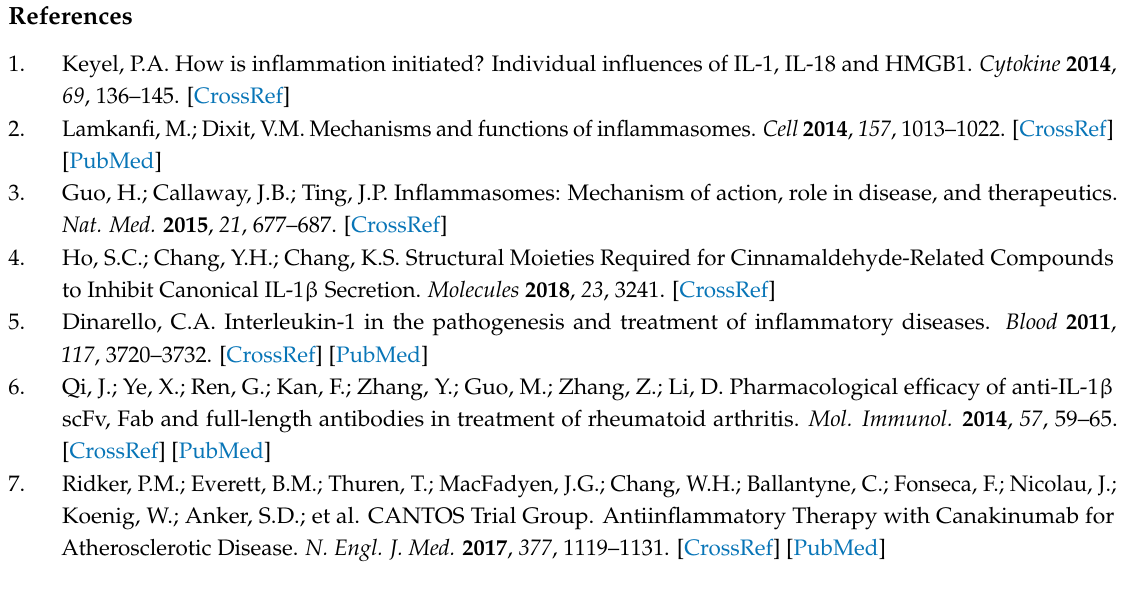
Figure 7. Cartoon pattern for mechanism of 6 against IL-1 β release [14,23].